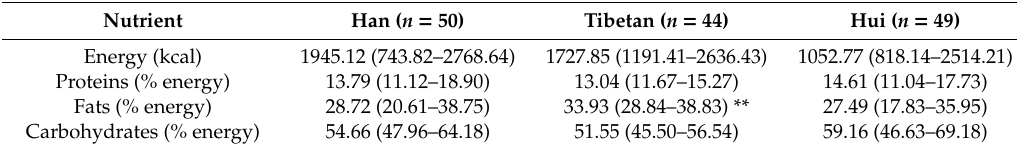
Table 2. Energy and mean percentage of energy from macronutrients among the three ethnic